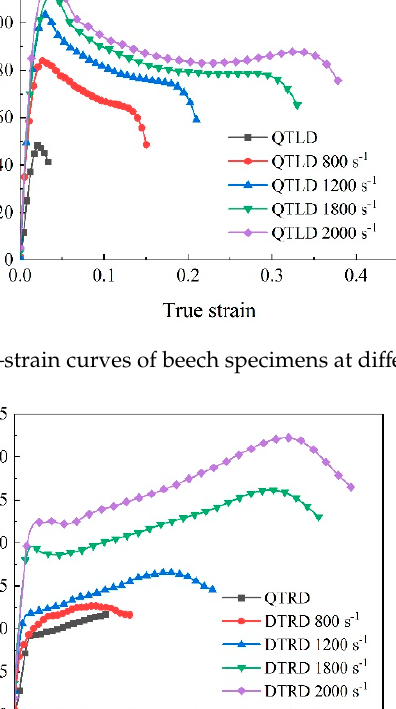
Table 1. Results from quasi-static compressive tests and SHPB compressive tests.